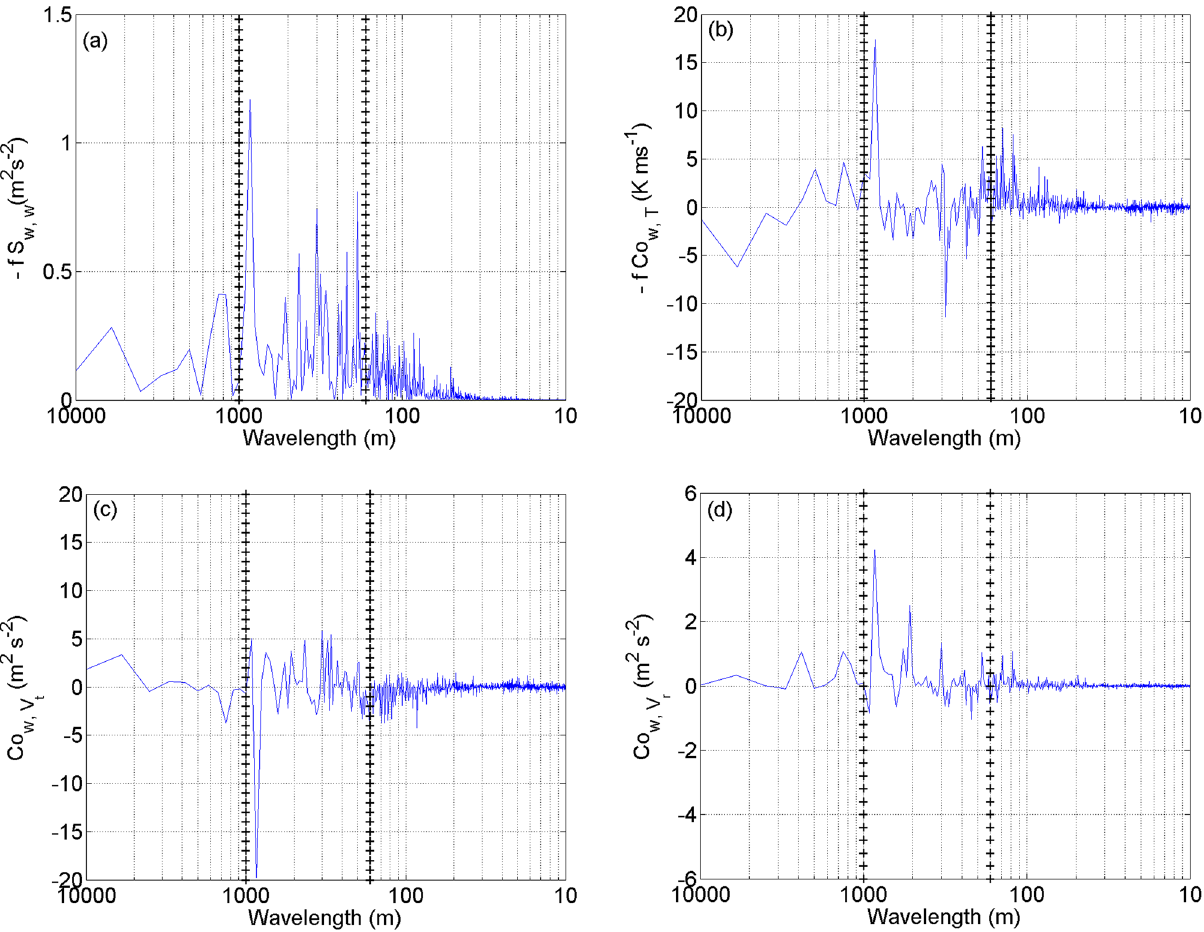
Figure 4. Plots of ( a ) spectra of vertical velocity (w), ( b ) cospectrum of w and temperature (T), ( c ) cospectrum of w and tangential wind speed (V